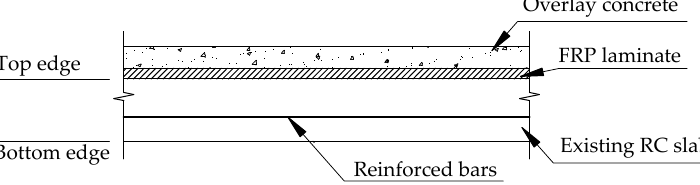
Figure 1. Hybrid FRP retrofit system for positive moment parts of strengthened RC slabs.